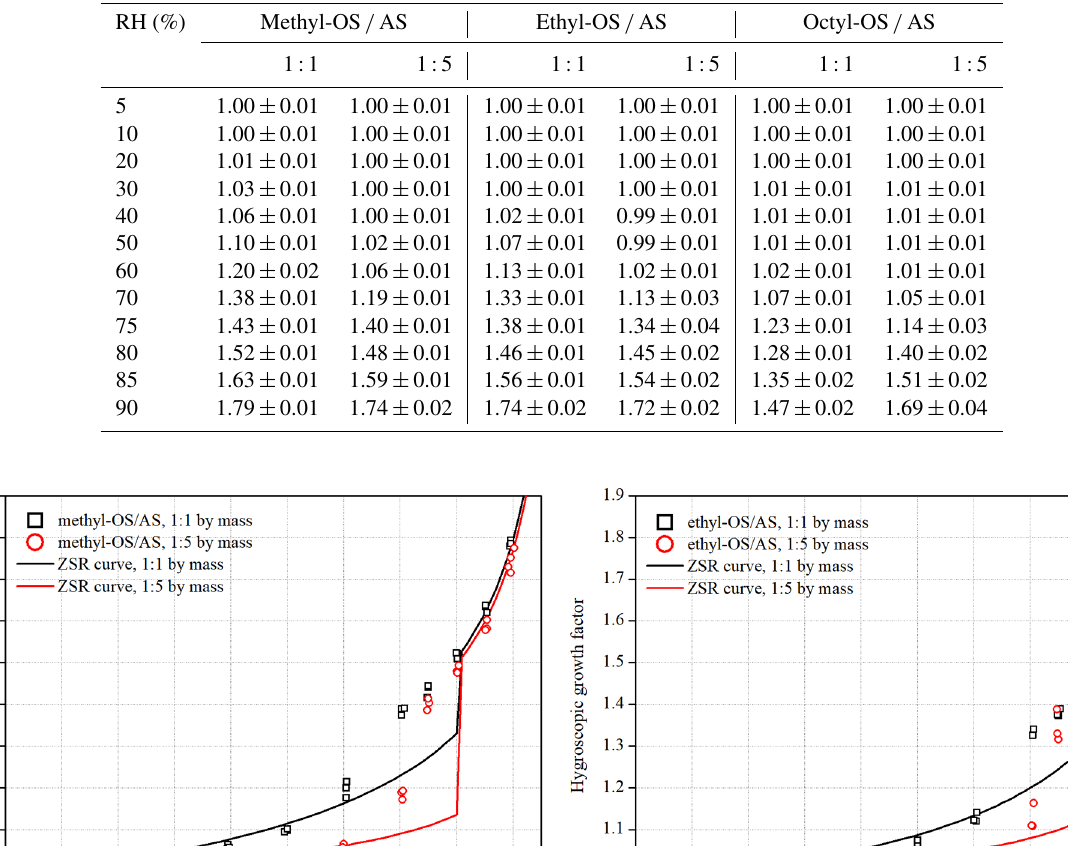
Table 4. Hygroscopic GF of methyl-, ethyl- and octyl-OS internally mixed with AS (their mass ratios are 1:1 and 1:5) at different RHs. All the errors given in this work are standard deviations.